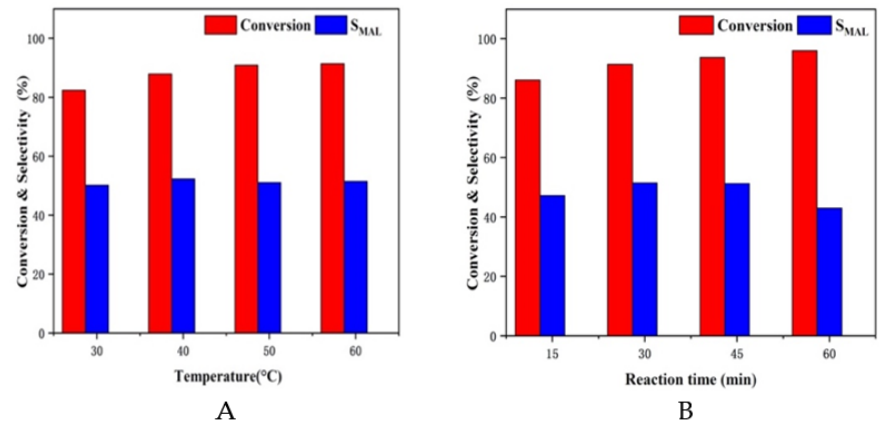
Figure 8. Results of the aldol condensation reaction of Mg 3 Al–Pro-LDHs under different tempera- tures ( A ) and different reaction times ( B ).